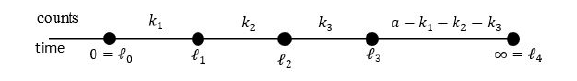
Figure 2. Representation of the time